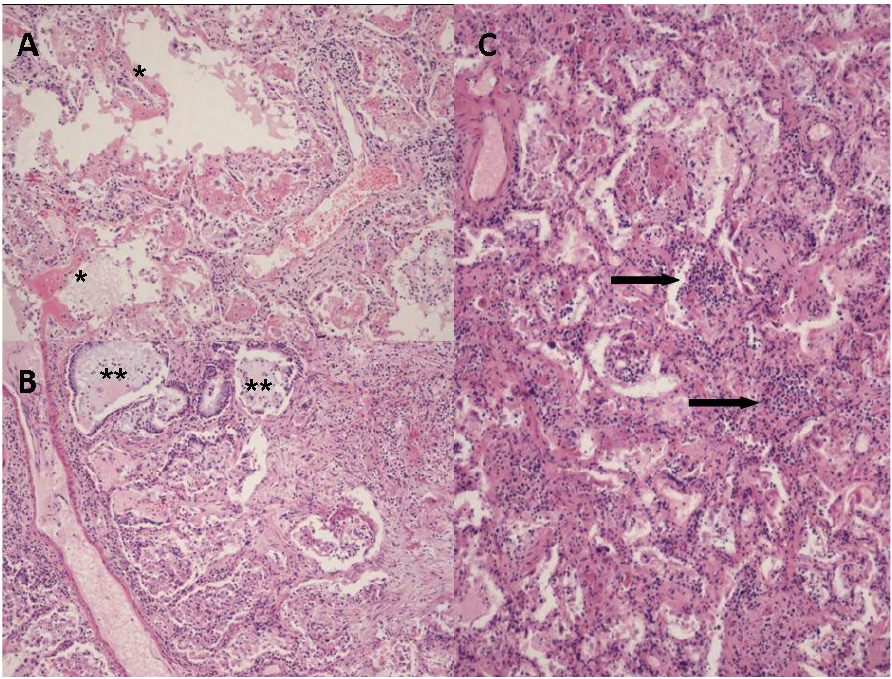
Figure 1. Hematoxylin and eosin-stained sections from representative areas of lung parenchyma with diffuse alveolar damage, characterized by plurifocal hyaline membranes (panel A , *), prominent type II pneumocyte hyperplasia and atypia (panel B , **) and chronic inflammatory infiltrate (lymphocytes and macrophages) (Panel C , black arrows). OM panels ( A ) and ( B ) 10×, panel ( C ) 20×. Platelet-fibrin thrombi in small arterial vessels (<1 mm in diameter) were found in three cases. In four out of the six autopsy cases, the histological examination showed the presence of fungal hyphae of Aspergillus spp. In three cases, fungi were associated with exudative inflammatory and necrotic lung lesions (two of them were large necrotic areas and fungal hyphae were abundant; one was a small area of exudative inflammation and fungal hyphae were rare); in the last, fourth case, fungi were found in the bronchial lumen, associated with acute inflammation and necrosis of the bronchial wall. Fungal angioinvasion was found in none of the four cases (Figure 2). PCR for SARS-CoV-2 was positive in all the lung tissues tested. PCR for Aspergillus spp. was positive in three out of the four cases with histological diagnosis of aspergillosis; the case that was negative was the one with the small area of exudative inflammation and rare hyphae.